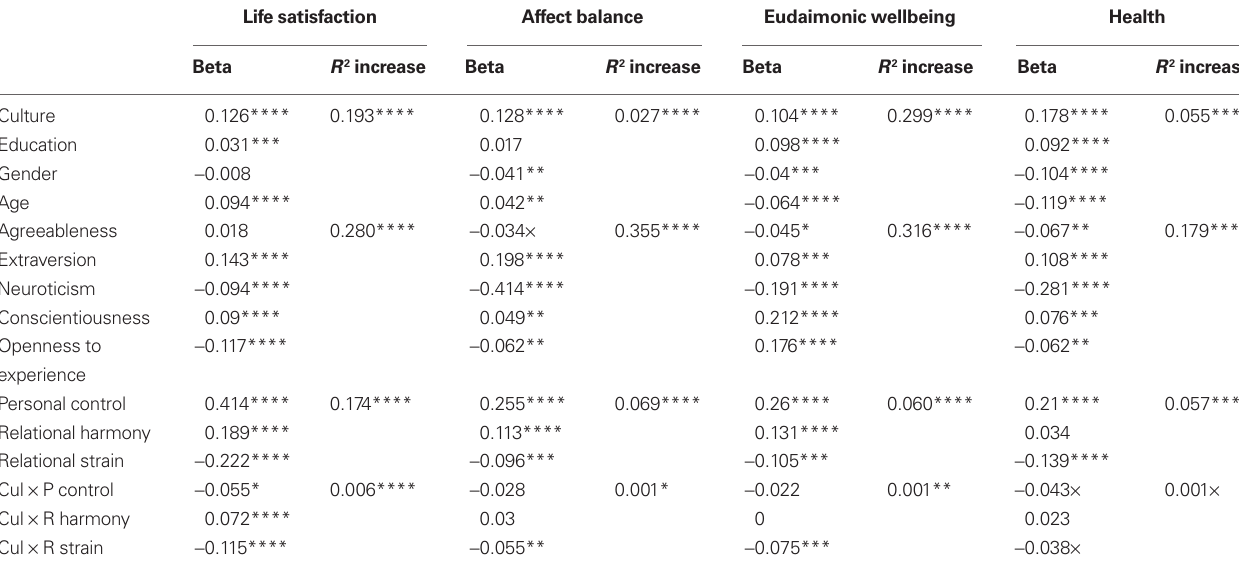
Table 3 | Summary of regression predicting life satisfaction, affect balance, eudaimonic wellbeing, and health as a function of demographics, personality, self, and culture and